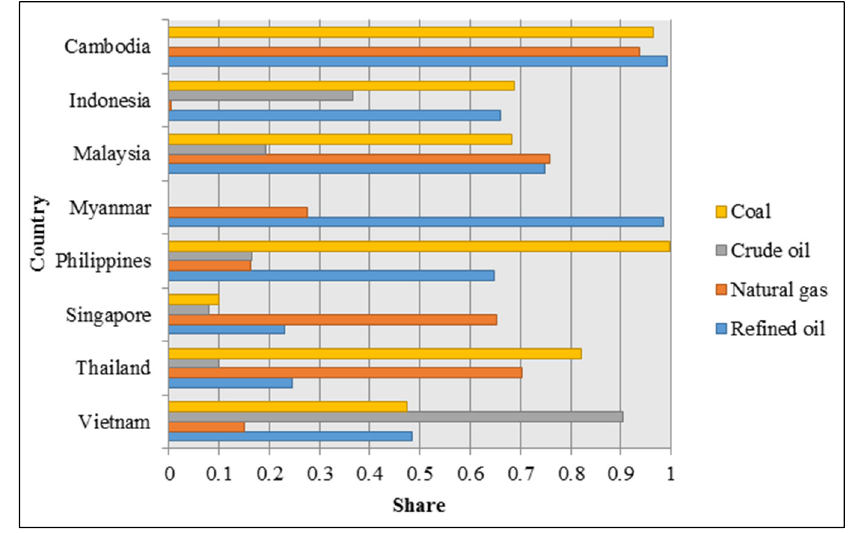
Figure 44. Share of intra-regional energy